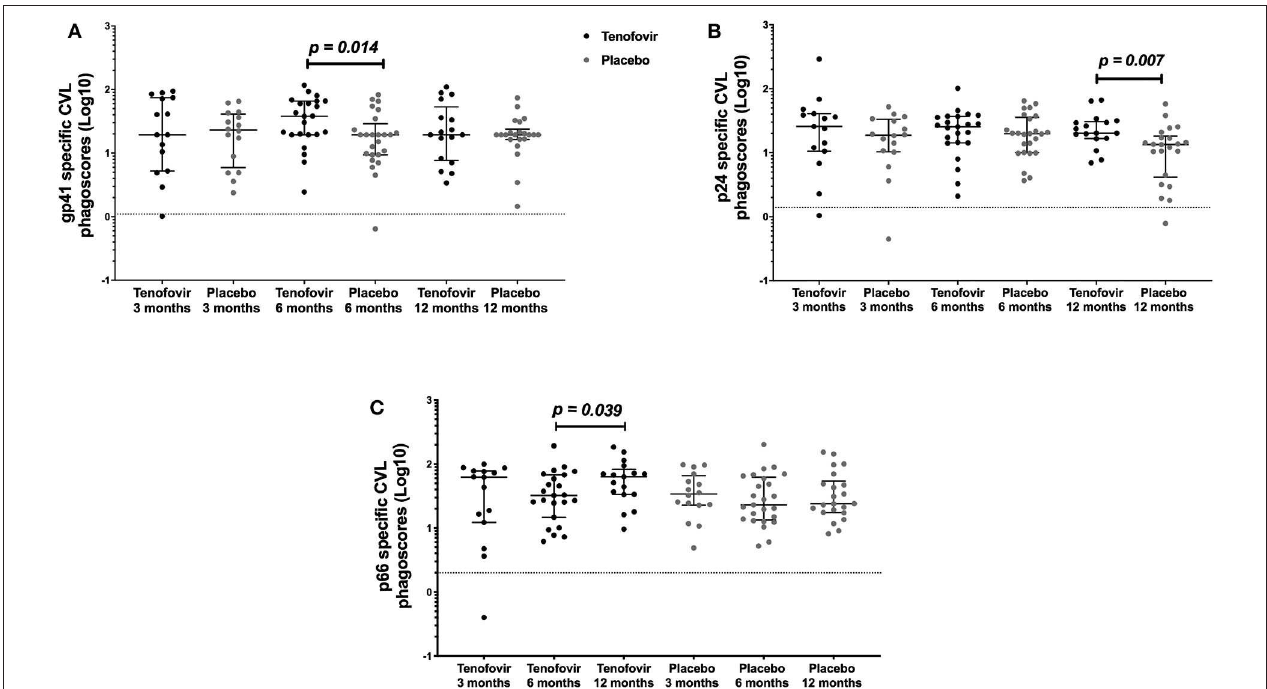
FIGURE 3 | HIV-specific ADNP [phagoscores (Log10)] in the genital tract (CVL) in women from the tenofovir and placebo arms. Cross-sectional analyses between the tenofovir and placebo arms to HIV proteins (A) gp41 and (B) p24 and longitudinal analyses for tenofovir and placebo (C) p66. Solid lines indicate the minimum and maximum values of box and whisker plots, with black solid lines across the dots indicate the median at each time point for each study arm. Wilcoxon signed-rank test was used to analyse ADNP activity over time and Wilcoxon-Mann-Whitney test was used for cross sectional analysis. Statistically significant values were defined as p < 0.05 with no adjustments for multiple